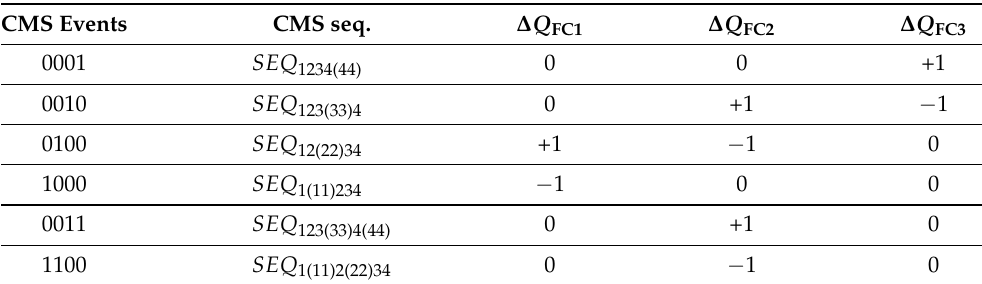
Table 2. Effect on charge increments of the FCs in dependence of different CMS events/sequences: (+1) charge, ( − 1) discharge, (0) no effect. Scaling the values by 2 ∆ Q S gives the charge increment